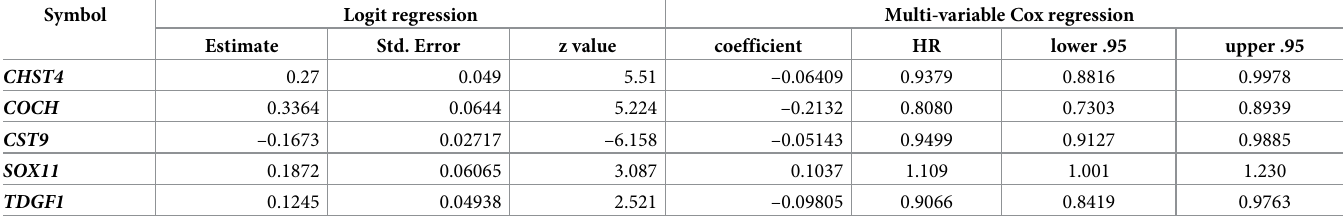
Table 2. Important DEG signature lists assessed through the Logit regression model and multi-variable Cox regression. Symbol Logit regression Multi-variable Cox